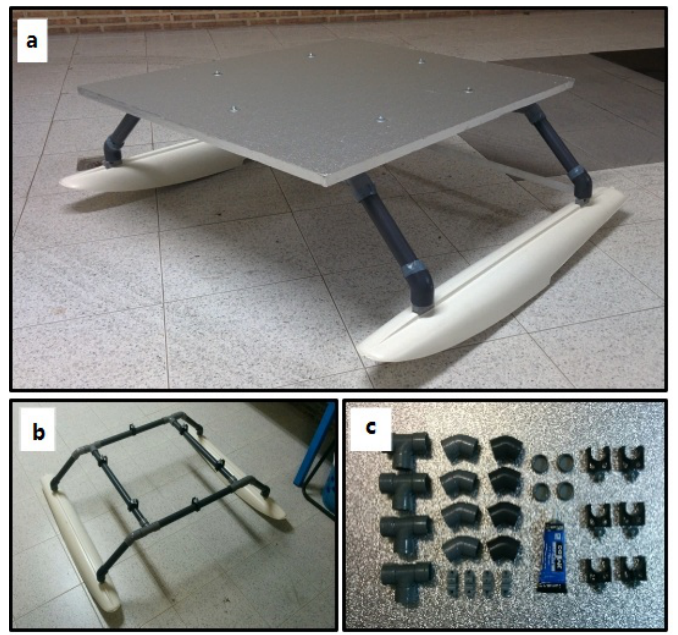
Figure 3. Material used in the structure construction: ( a ) Final assembly, ( b ) Structure without the polyurethane foam base, ( c ) The PVC materials used.